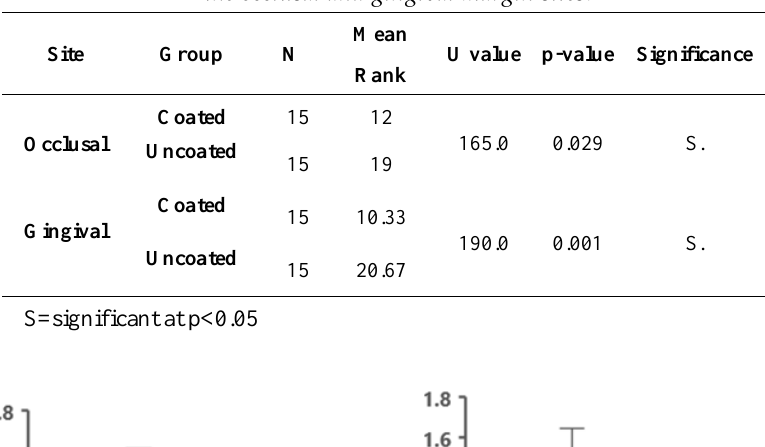
Table 1: Mann Whitney U test compares the microleakage between the coated and uncoated CeraBur groups at the occlusal and gingival margin sites.